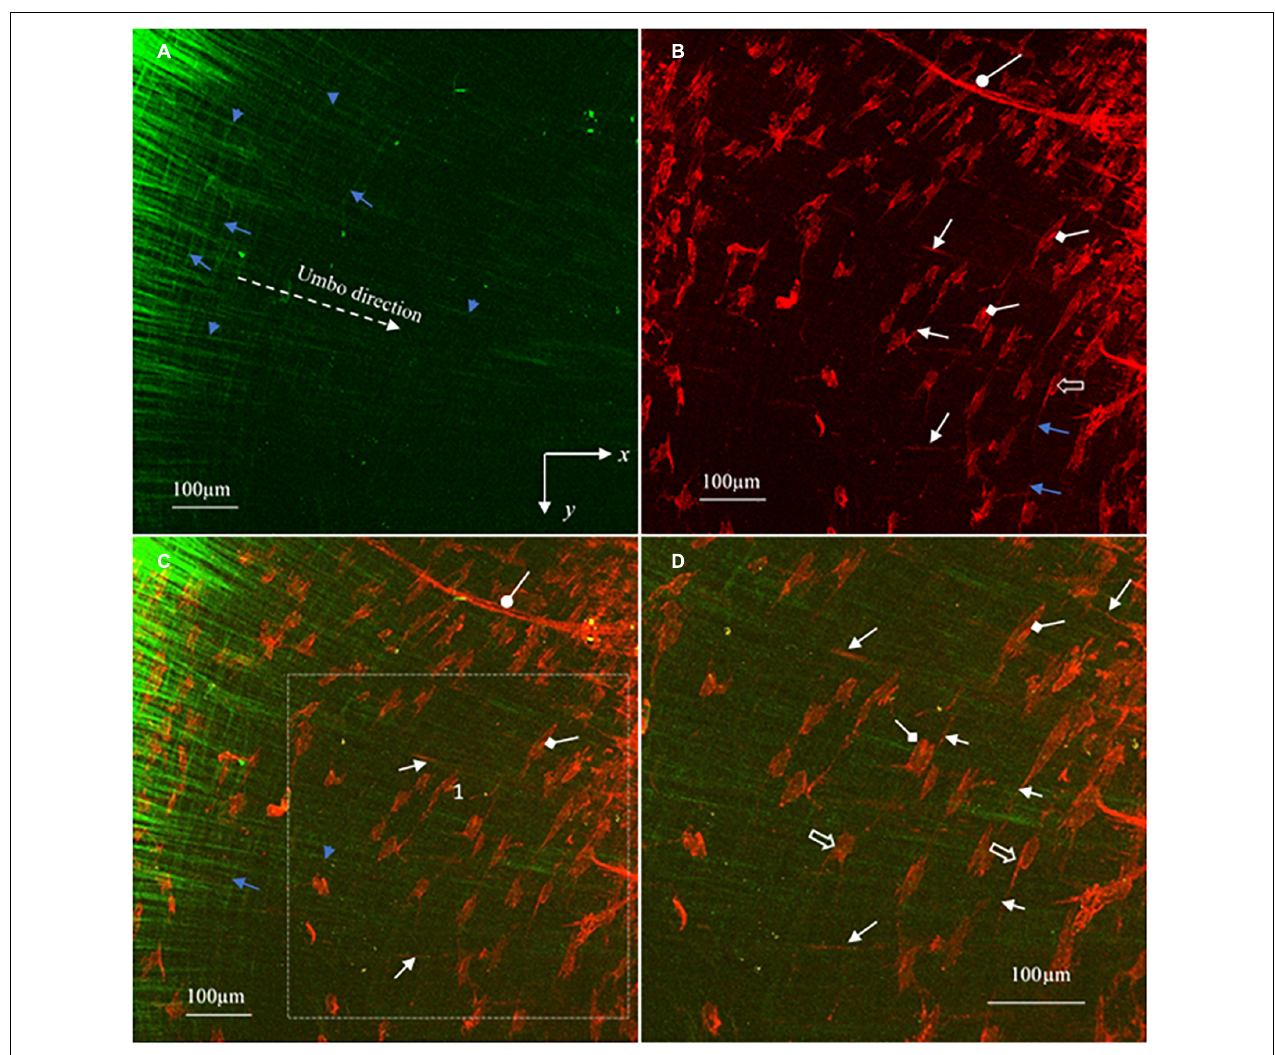
FIGURE 6 | MBIs reconstructed from the image stacks in Figure 5 show in more detail the characteristics of the collagen (green), elastic fibers (white arrows), vimentin positive cells (hollow arrows), cell nuclei (diamond arrows) and capillaries (oval arrows) of the pars tensa near the TM center. (A) The collagen fibers gradually become finer approaching the TM center. (B) The corresponding TPF image shows the elastic fibers (white arrows), capillaries (oval arrow) and vimentin positive cells (hollow arrow) with the nuclei (diamond arrow). (C) The merged image dedicates the composition of the collagen fibers (green) with the cells, capillaries and elastic fibers. (D) An enlarged image extracted from region 1 of panel (C) highlight the characteristics of the fine collagen fibrils (green), elastic fibers (white arrows), vimentin positive cells (hollow arrow) and the cell nuclei (diamond arrow) of the pars tensa near the TM center. There is an apparent increase of the population of the vimentin positive cells near the TM